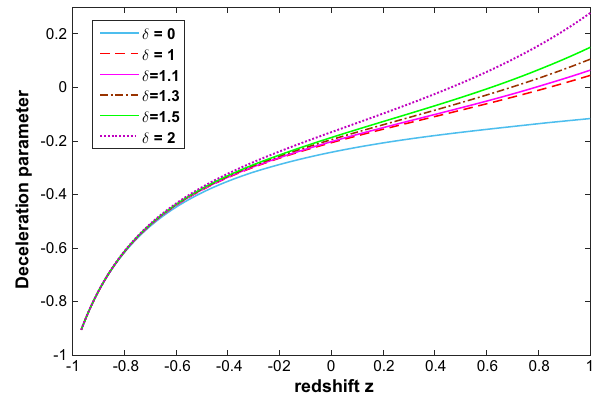
Fig. 3 Plot of deceleration parameter of non-interacting THDE model versus redshift z for β 1 = 7 . 1, β 2 = 2 . 15, w = 1000, Ω 0 u = 0 . 3